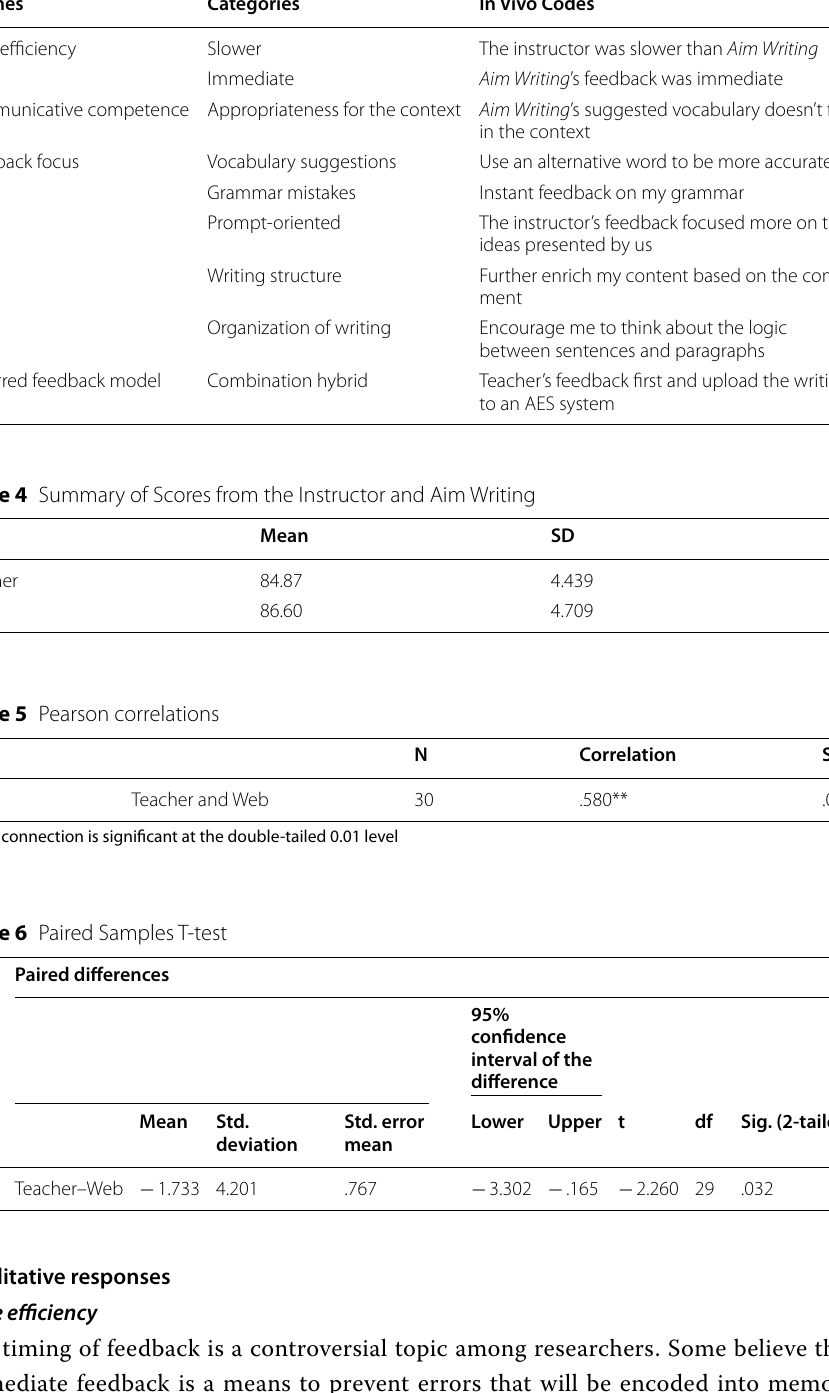
Table 3 Themes, categories, and codes extracted from the interviews Themes